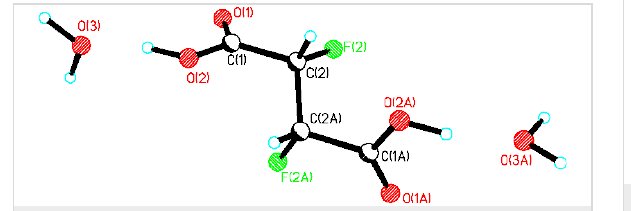
Figure 6: X-ray structure of threo - 19